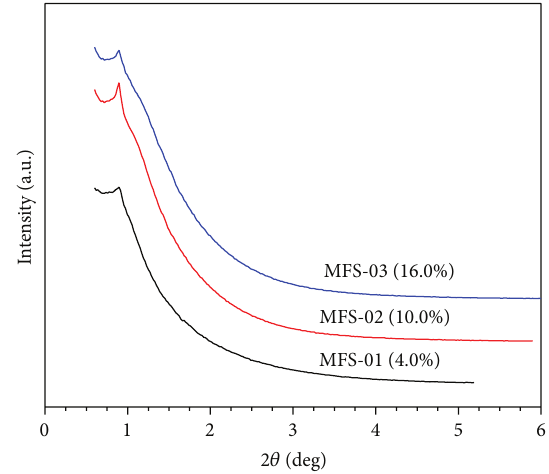
Figure 2: PXRD pattern of the synthesized MFS crystals.